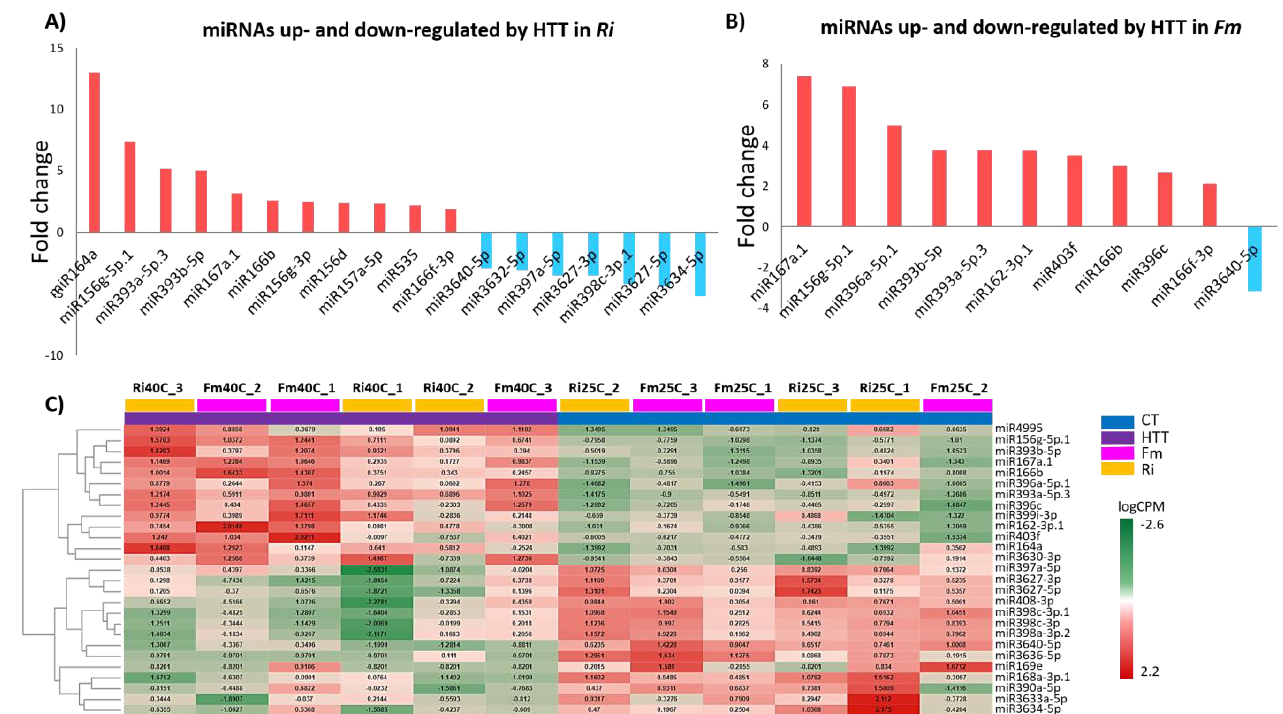
Figure 2. MiRNAs up – or downregulated by high-temperature treatment (HTT — 40 °C) in mycor- Figure 2. MiRNAs up- or downregulated by high-temperature treatment (HTT—40 ◦ C) in mycor- rhizal plants: ( A ) miRNAs up – and downregulated by HTT — 40 °C in R. irregulare inoculated plants, rhizal plants: ( A ) miRNAs up- and downregulated by HTT—40 ◦ C in R. irregulare inoculated plants, ( B ) miRNAs up- and downregulated by HTT — 40 °C in F. mosseae inoculated plants, and ( C ) ( B ) miRNAs up- and downregulated by HTT—40 ◦ C in F. mosseae inoculated plants, and ( C )